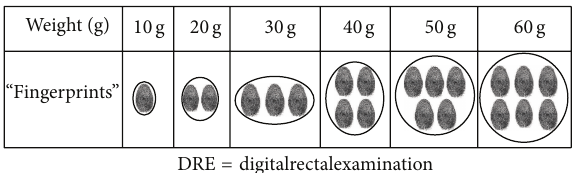
Figure 1: Scaled standardization of clinical impression of prostate weight (1g = 1cc) by DRE based on fingertips graphical schema.